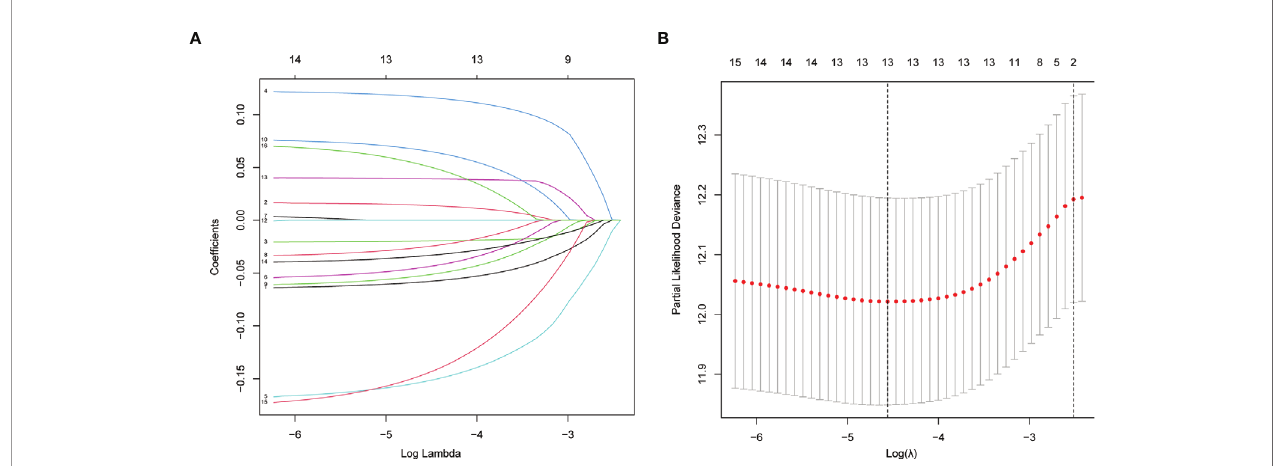
FIGURE 2 | Establishment of prognostic gene signature by LASSO regression analysis. (A) LASSO coef fi cient pro fi les of the 16 genes in LUAD. A coef fi cient pro fi le plot was generated against the log (lambda) sequence. (B) Selection of the optimal parameter (lambda) in the LASSO model for LUAD.